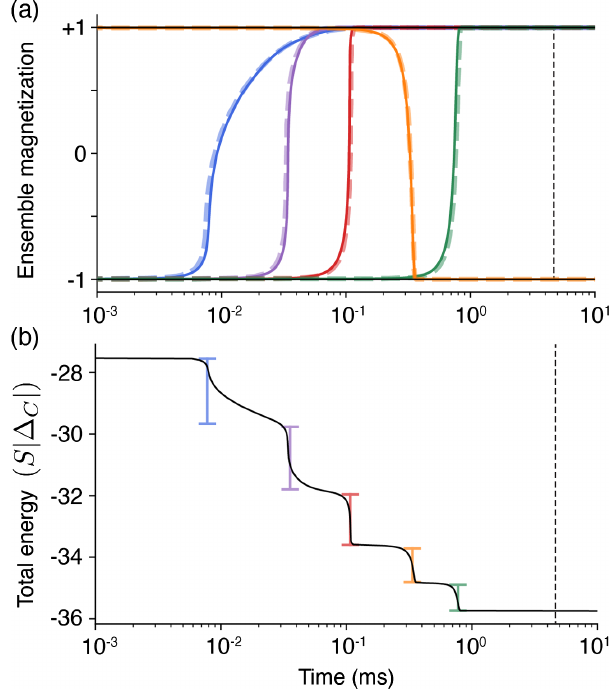
FIG. 9. (a) Simulation of a system of N ¼ 100 ensembles. All are initialized in a local minimum state except five ensembles that are flipped in the wrong orientation. Each ensemble is composed of M ¼ 2 S ¼ 10 5 spins. For this (realistic) number of spins, the statistical fluctuations, which are present, are not